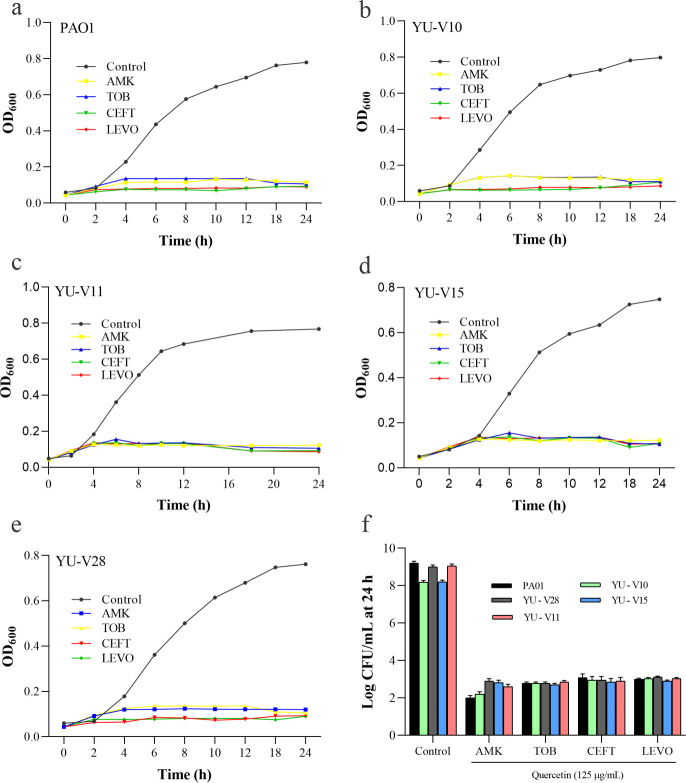
Time kill assay data showing the growth pattern of P. aeruginosa strains treated with antibiotic-quercetin combinations at lowest FICi for 24 h.(a-e) represents five different strains. (f) shows the CFU/mL data obtained from the cultures of 24 h incubation by serial dilution plate method.